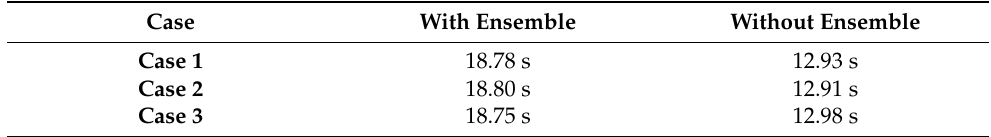
Table 5. Comparison of computation time concerning the proposed model with ensemble thinking and the proposed model without ensemble